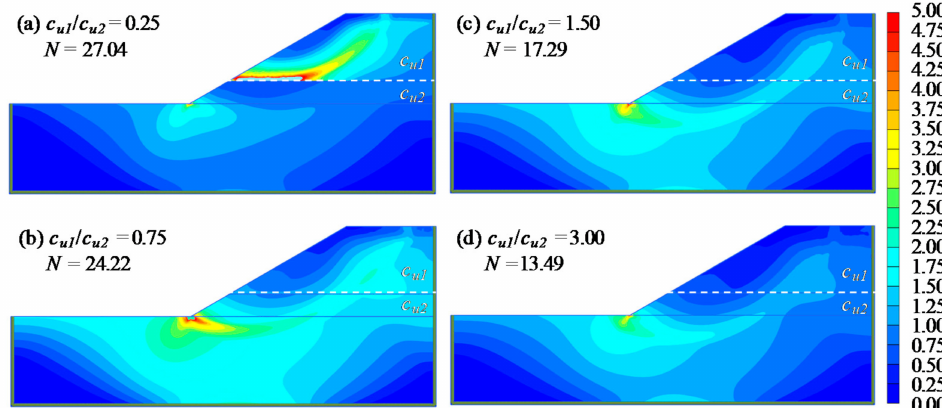
Figure 10. Total deviatoric strain according to c u 1 / c u 2 , where T / H = 2, H / B = 0.5, β = 30 ◦ , D / H = 0.75